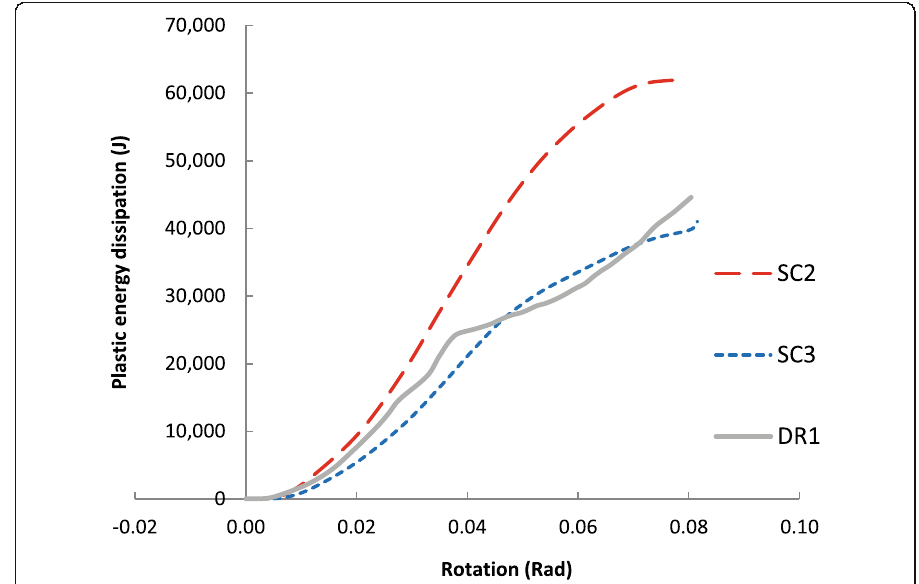
Fig. 29 Plastic energy dissipation for connections SC2, SC3, and DR1 under blast loading and blast duration 0.02